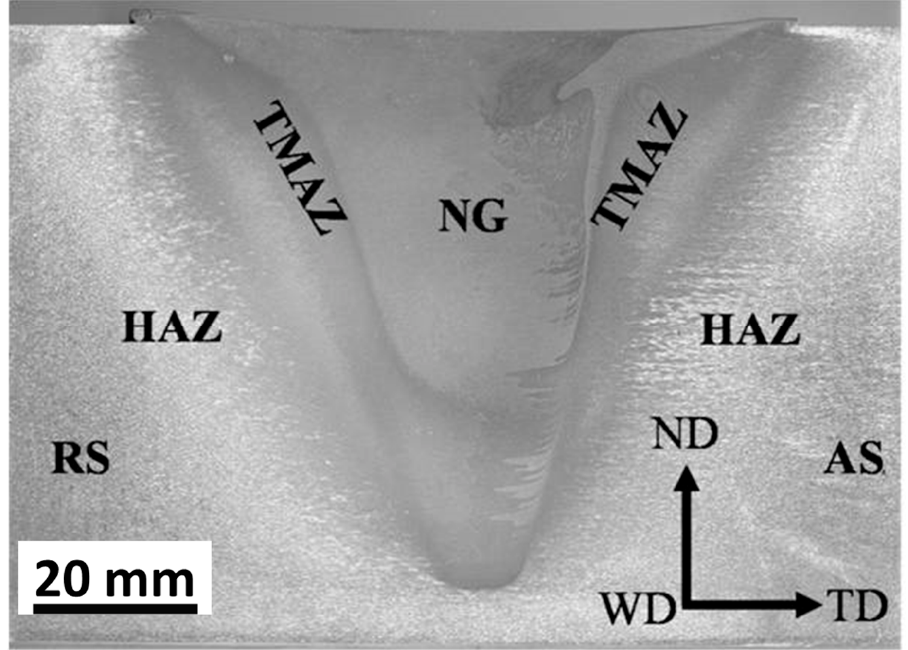
Figure 5. Transverse cross-section optical macrograph of friction-stir-welded 75 mm-thick AA6082 on which the different zones are labeled. TD, WD, and ND stand for transverse direction, welding direction, and normal direction, respectively.